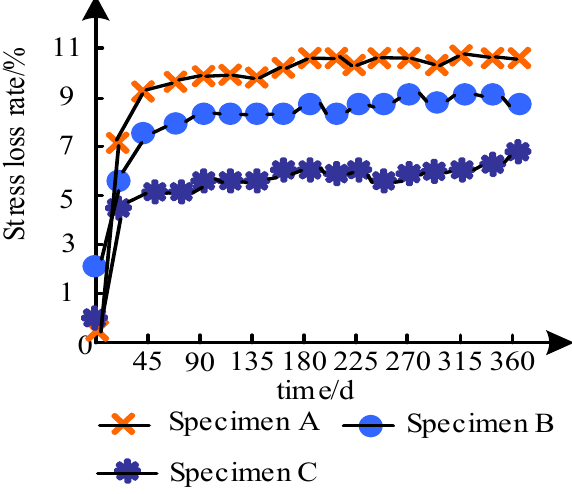
Figure 3. Time–history curve of stress loss rate of the prestressed bolt structure.